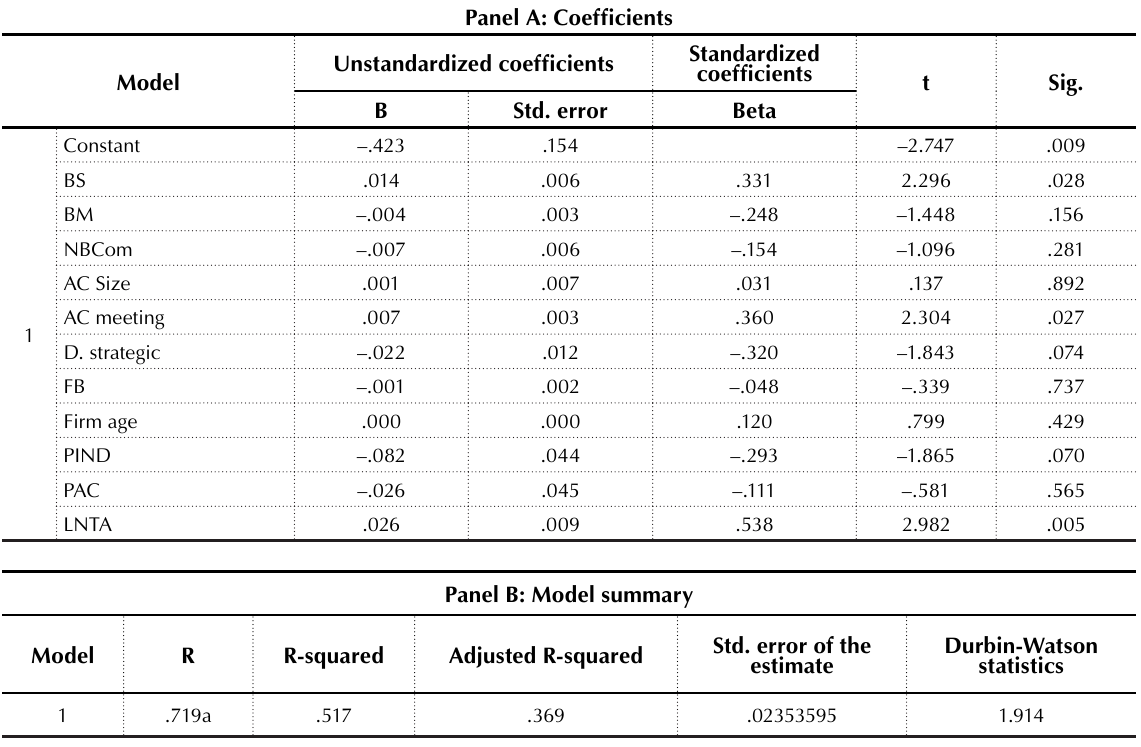
Table 6. Regression results – Dependent variable –